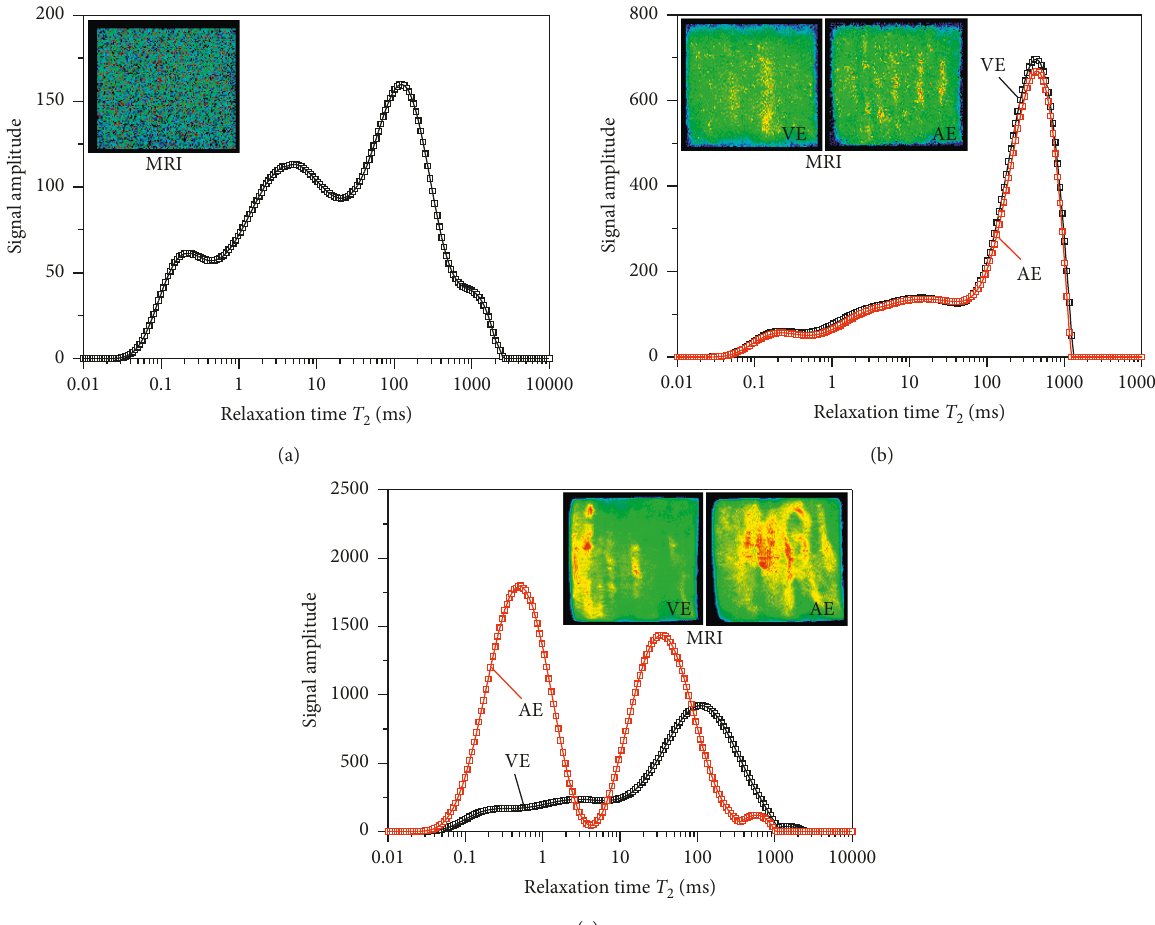
Figure 8: T 2 curves and MRI images obtained by NMR: (a) 25, (b) 450, and (c) 750